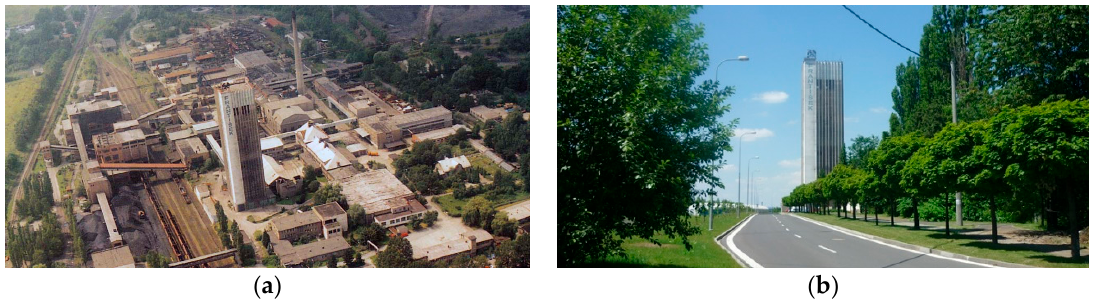
Figure 2. The tower in the operation period of the 1980s ( a ) and presently ( b ). The SAM Hi 30 AUTO WIND is a fully automatic, remote-controlled sampler intended for gravimetric and chemical analyses of aerosol particles. The device samples particulate